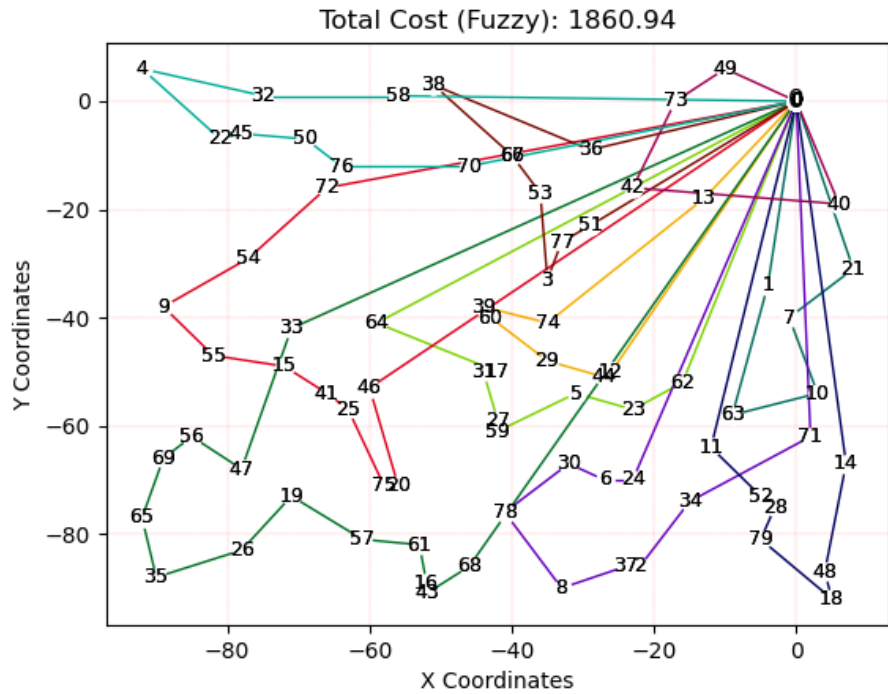
Figure 13. Best solution for VRP-Fuzzy